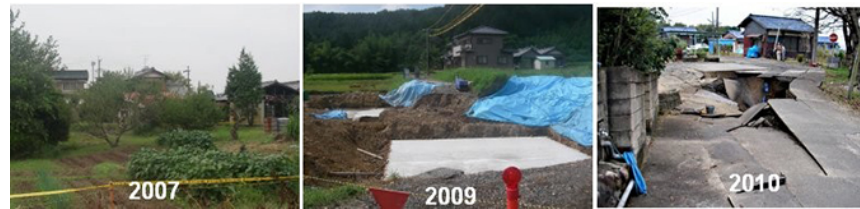
Figure 2. Large sinkholes occurred recently over the abandoned lignite mine in Mitake town.